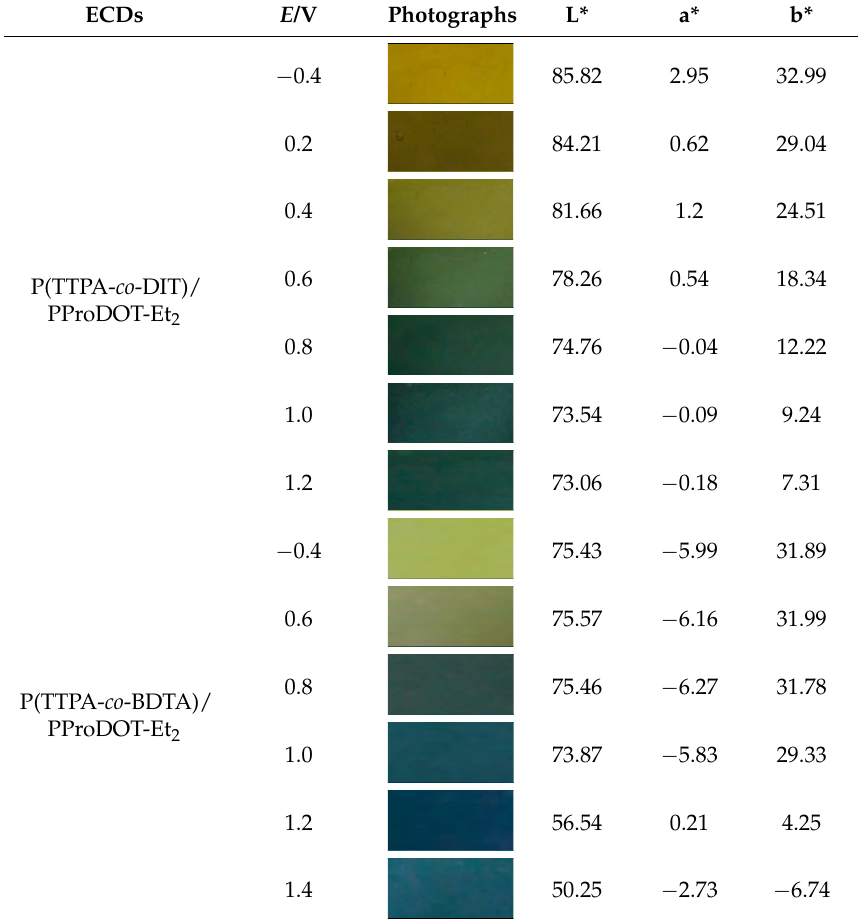
Electrochromic photographs and colorimetric values (L*, a*, and b*) of the ECDs. The P(TTPA- co -DIT) and P(TTPA- co -BDTA) films were prepared potentiostatically at 1.0 V on ITO glass electrodes.